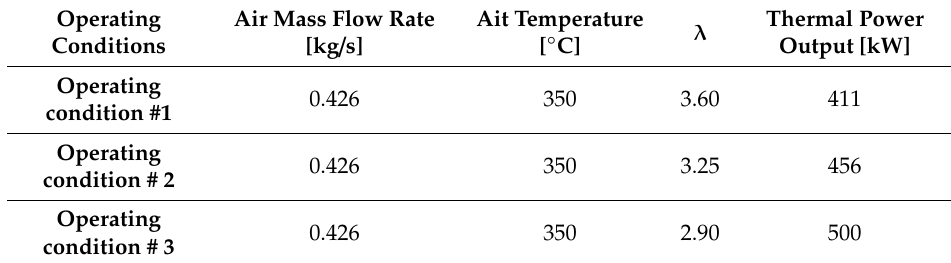
Table 1. Burner test